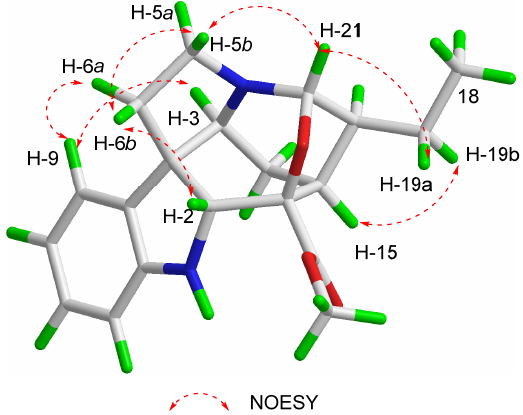
Figure 3. Key NOESY correlations of 1 .